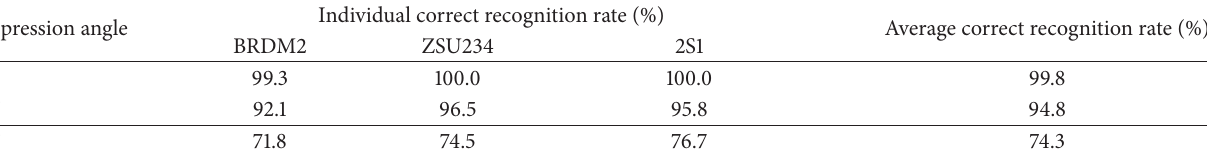
Table 4: Recognition results with variant depression angles